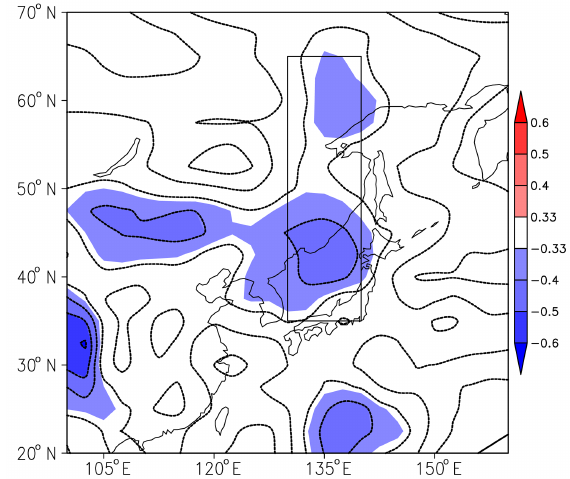
Figure 2. The CC between WHD NCP DY and SAT DY in autumn from 1980 to 2013. The shades indicate that the CC exceeded the 95% confidence level, and the rectangle represents the selected re- gion (35–65 ◦ N, 130–140 ◦ E) of predictor x 1